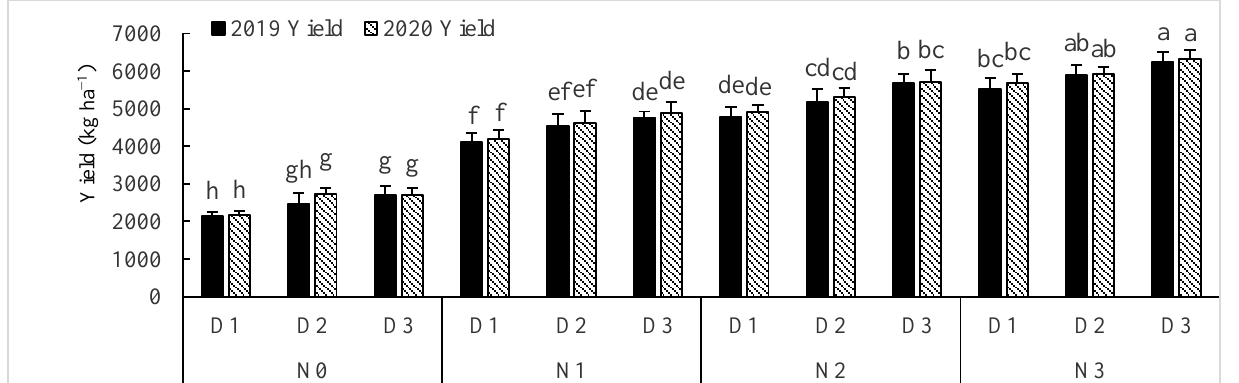
Figure 1. The interaction of increasing density and decreasing N on yield of wheat. Values are means ± SD (n = 3). Different letters above columns indicate significant difference within the same year under the treatments of four nitrogen levels and three plant densities by LSD test (ANOVA) at the 5% level. Four N fertilization levels—N0: 0 kg ha −1 ; N1: 120 kg ha −1 ; N2: 180 kg ha −1 ; N3: 240 kg ha −1 . Three plant densities—D1: 180 × 10 4 basic seedlings ha −1 ; D2: 240 × 10 4 basic seedlings ha −1 ; D3: 300 × 10 4 basic seedlings ha −1 .